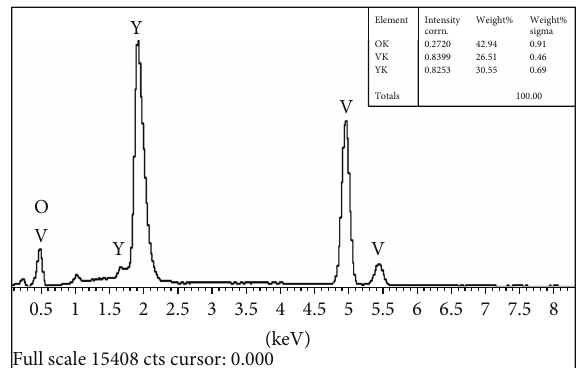
Figure 13: EDS spectrum from the rod/flat or needle crystals of YVO 4 on the surface of YSZ layer of